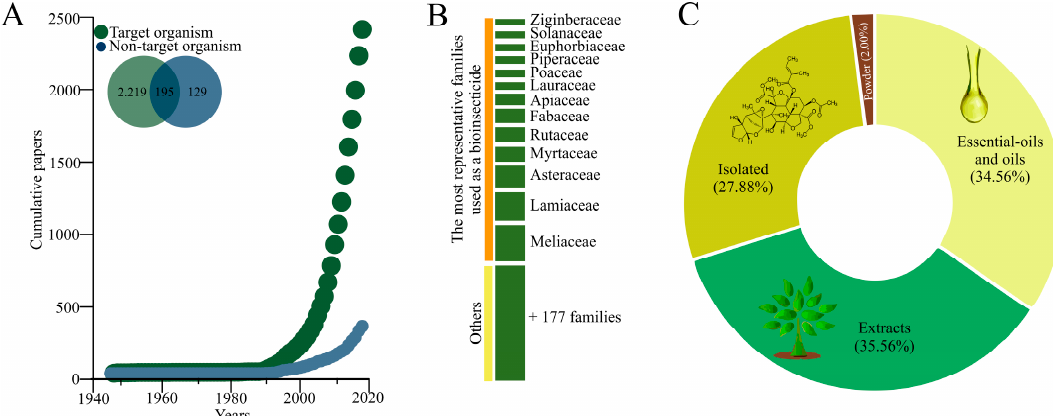
Figure 2. ( A ) Scatterplot of the cumulative number of manuscripts with botanical insecticides published between 1945–2019; ( B ) major plant families explored searching for botanical insecticides; ( C ) and type of formulation / composition used in studies with botanicals